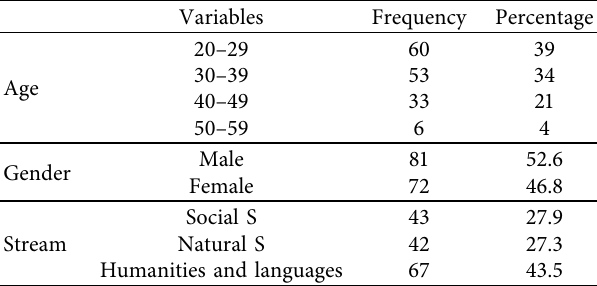
Table 1: Demographic profile of the